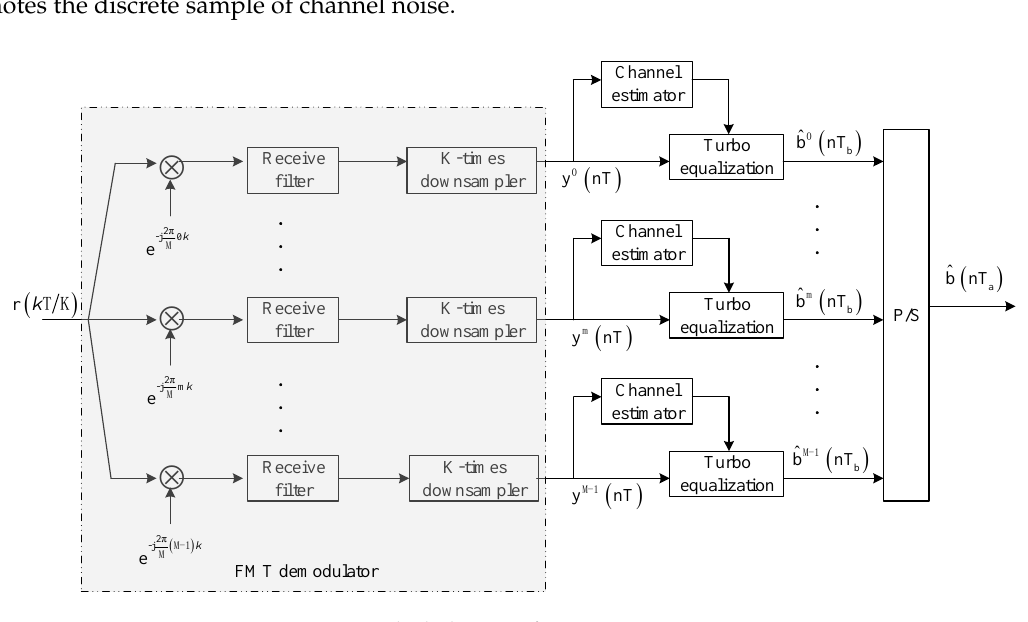
Figure 2. Block diagram for receiver structure.